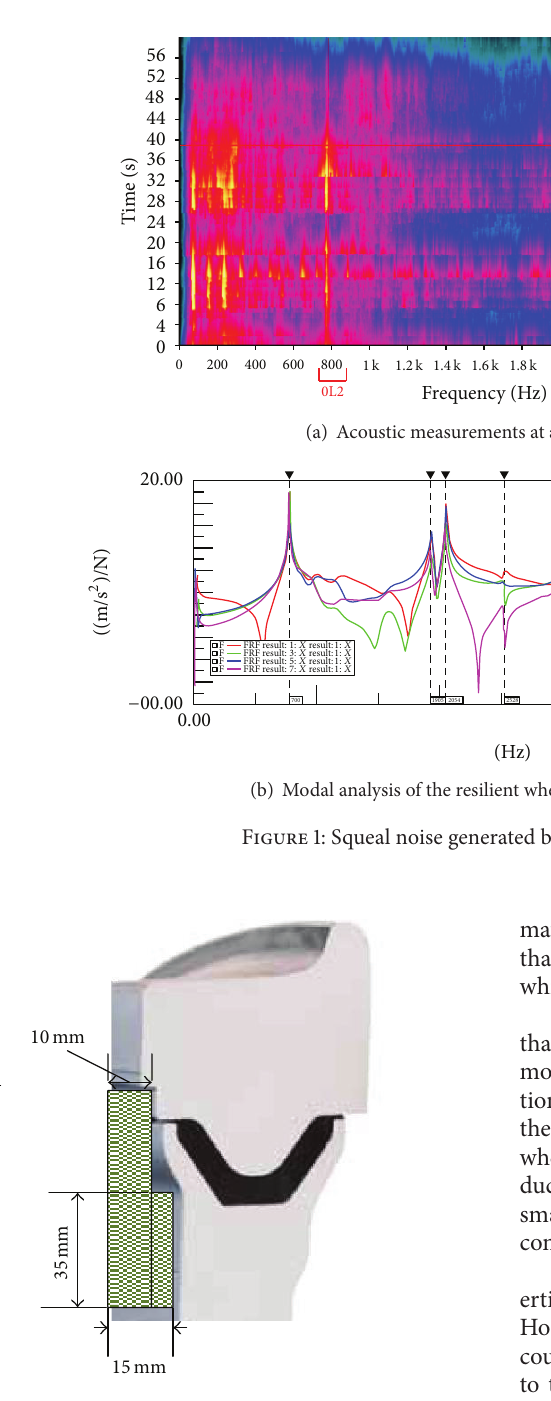
Figure 2: Geometric limitations to CLD